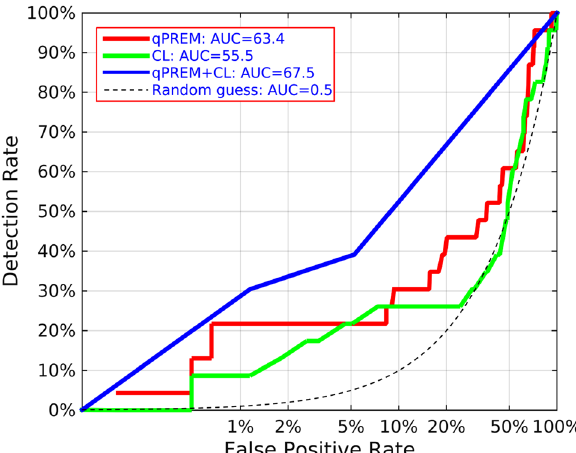
Figure 2. ROC curve for sPTB < 37 weeks. qPREM (Red) = automated cervical texture analysis tool. CL(Cyan): Cervical Length. qPREM + CL (blue) = both tools combined. Black dashed curve = random guess. X axis is shown in logarithmic scale to focus on low False Positive Rates, the only useful from a clinical perspective for sPTB prediction during mid-trimester screening of general population.